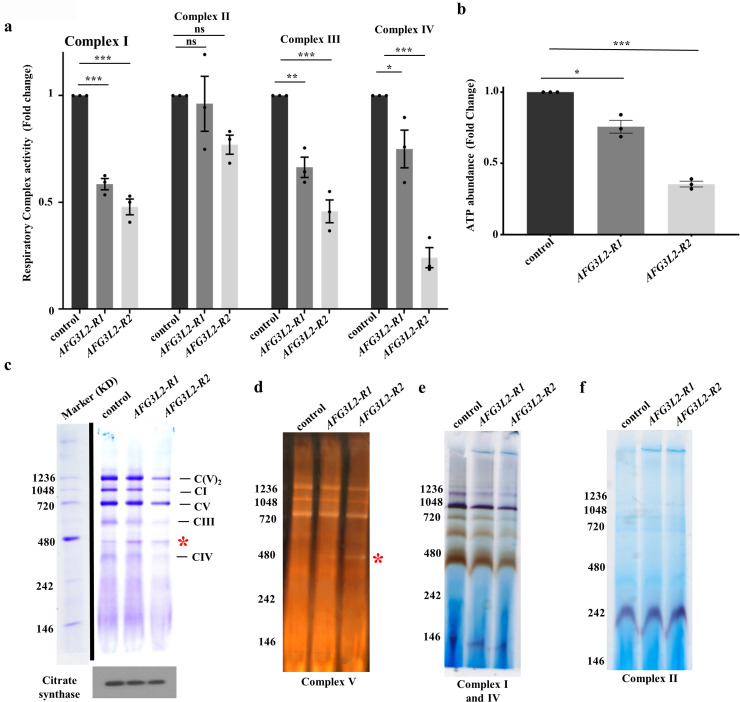
Afg3l2 deficiency confers diminished RC activity and abundance.a. RC activity in mitochondria isolated from control (UAS-LUCIFERASE RNAi/da-Gal4) and AFG3L2-deficient (UAS-AFG3L2-R1 RNAi; da-Gal4 and UAS-AFG3L2-R2 RNAi/da-Gal4) pupae (N = 3 independent biological replicates, *p < 0.05, **p < 0.005, ***p < 0.0005 by one way ANOVA Tukey's test for multiple comparison). b. ATP abundance in control (UAS-LUCIFERASE RNAi/da-Gal4) and AFG3L2-deficient (UAS-AFG3L2-R1 RNAi; da-Gal4 and UAS-AFG3L2-R2 RNAi/da-Gal4) pupae (N = 3 independent groups of 5 pupae, *p < 0.05, ***p < 0.0005 by one way ANOVA Tukey's test for multiple comparison). c. BN-PAGE of mitochondrial protein extracts from control (UAS-LUCIFERASE RNAi/da-Gal4) and AFG3L2-deficient (UAS-AFG3L2-R1 RNAi; da-Gal4 and UAS-AFG3L2-R2 RNAi/da-Gal4) pupae. Citrate synthase abundance was used as a loading control. Results of in-gel activity assays of mitochondrial complexes V (d), I and IV (e), and II (f) using the mitochondrial protein extracts from (c). The red asterisk in (c) and (d) denotes the location of the sub-complex containing the F1 subunit of ATP synthase in AFG3L2-deficient animals. For BN-PAGE and in-gel activity assays, images shown here are representative of two independent biological replicates.